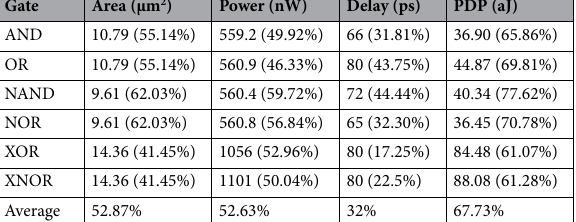
Table 23. Analysis of design overheads for XOR based logic encryption along with % of improvements when compared with proposed logic encryption.